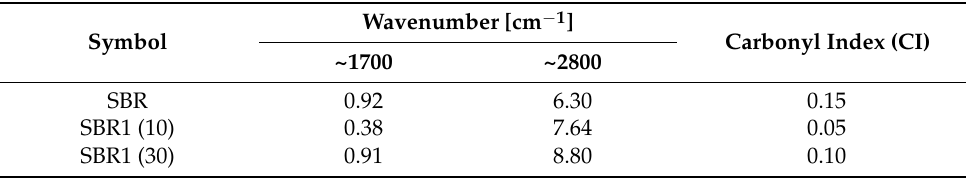
Table 6. Carbonyl index for samples after thermo-oxidative